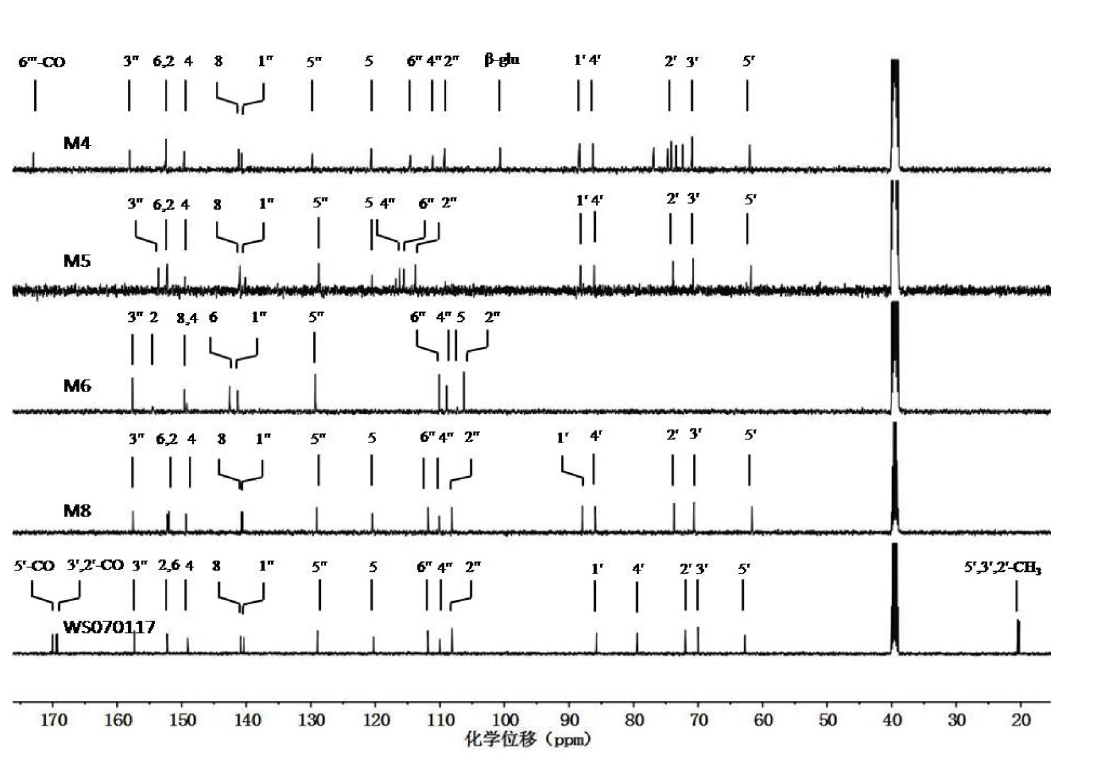
Fig 4. The stack of 13 C NMR spectra of WS010117 and its four metabolites (in DMSO-d 6 ).